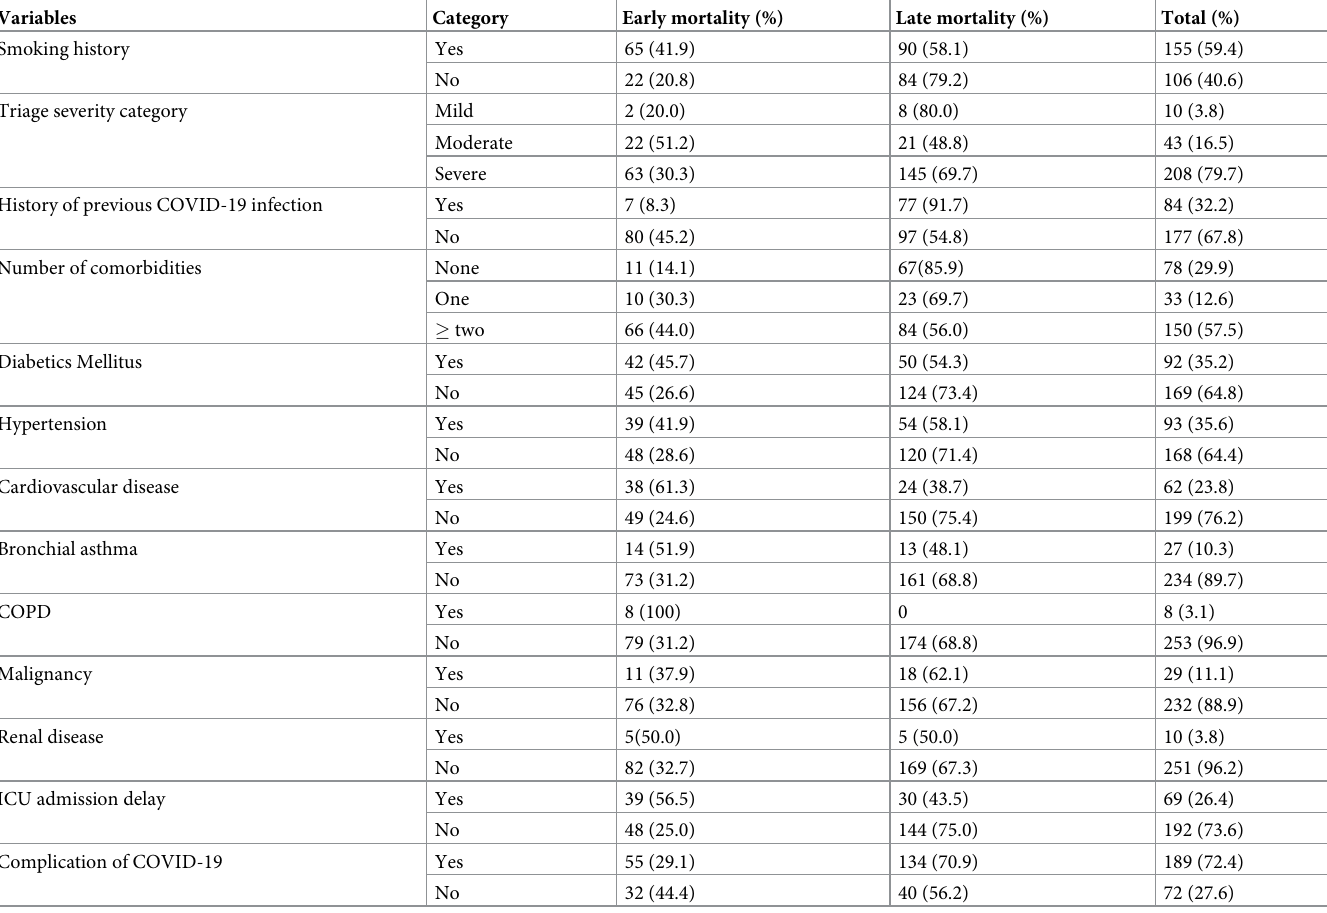
Table 2. Comorbidities and other clinical related characteristics between early mortality and late mortality among COVID-19 patients at Addis Ababa COVID-19 care centers, Ethiopia, 2022 (n =